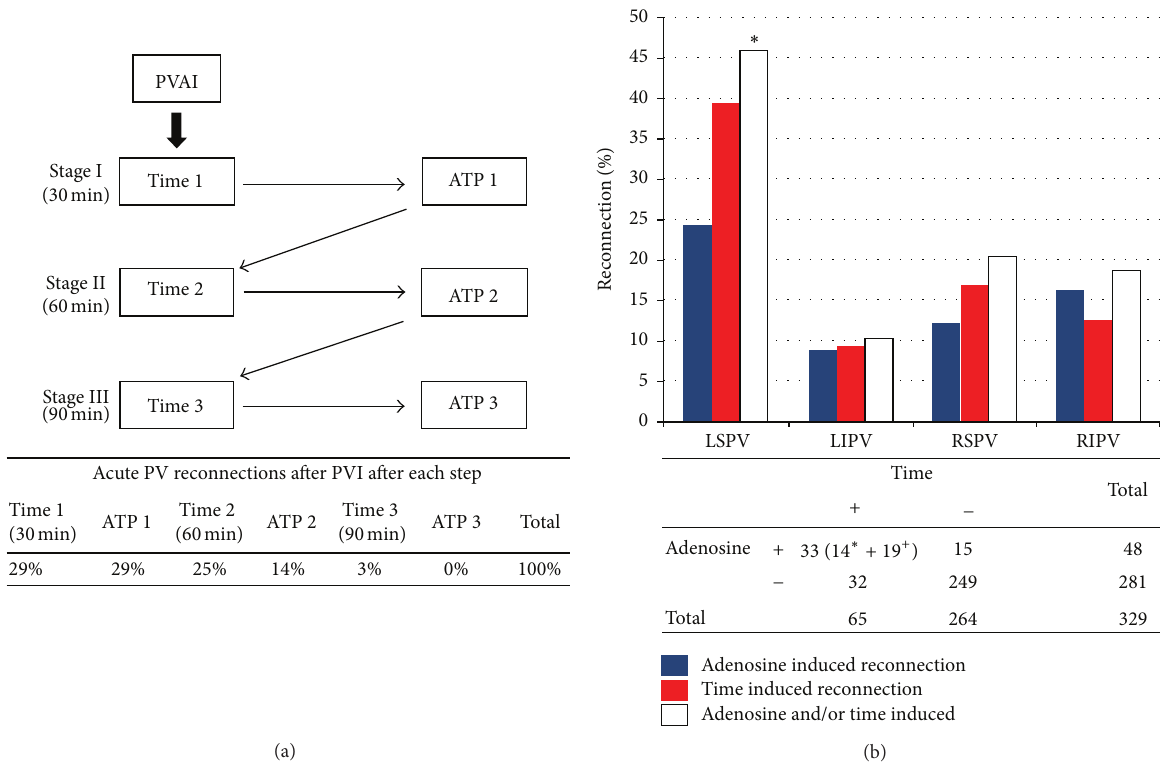
Figure 5: (a) Study algorithm and results from Yamane et al. [32]; PVAI: pulmonary vein isolation, ATP: Adenosine Triphosphate. (b) Incidence of reconnection in individual pulmonary veins mediated by adenosine and/or time, adapted from Jiang et al. [33] (see text for